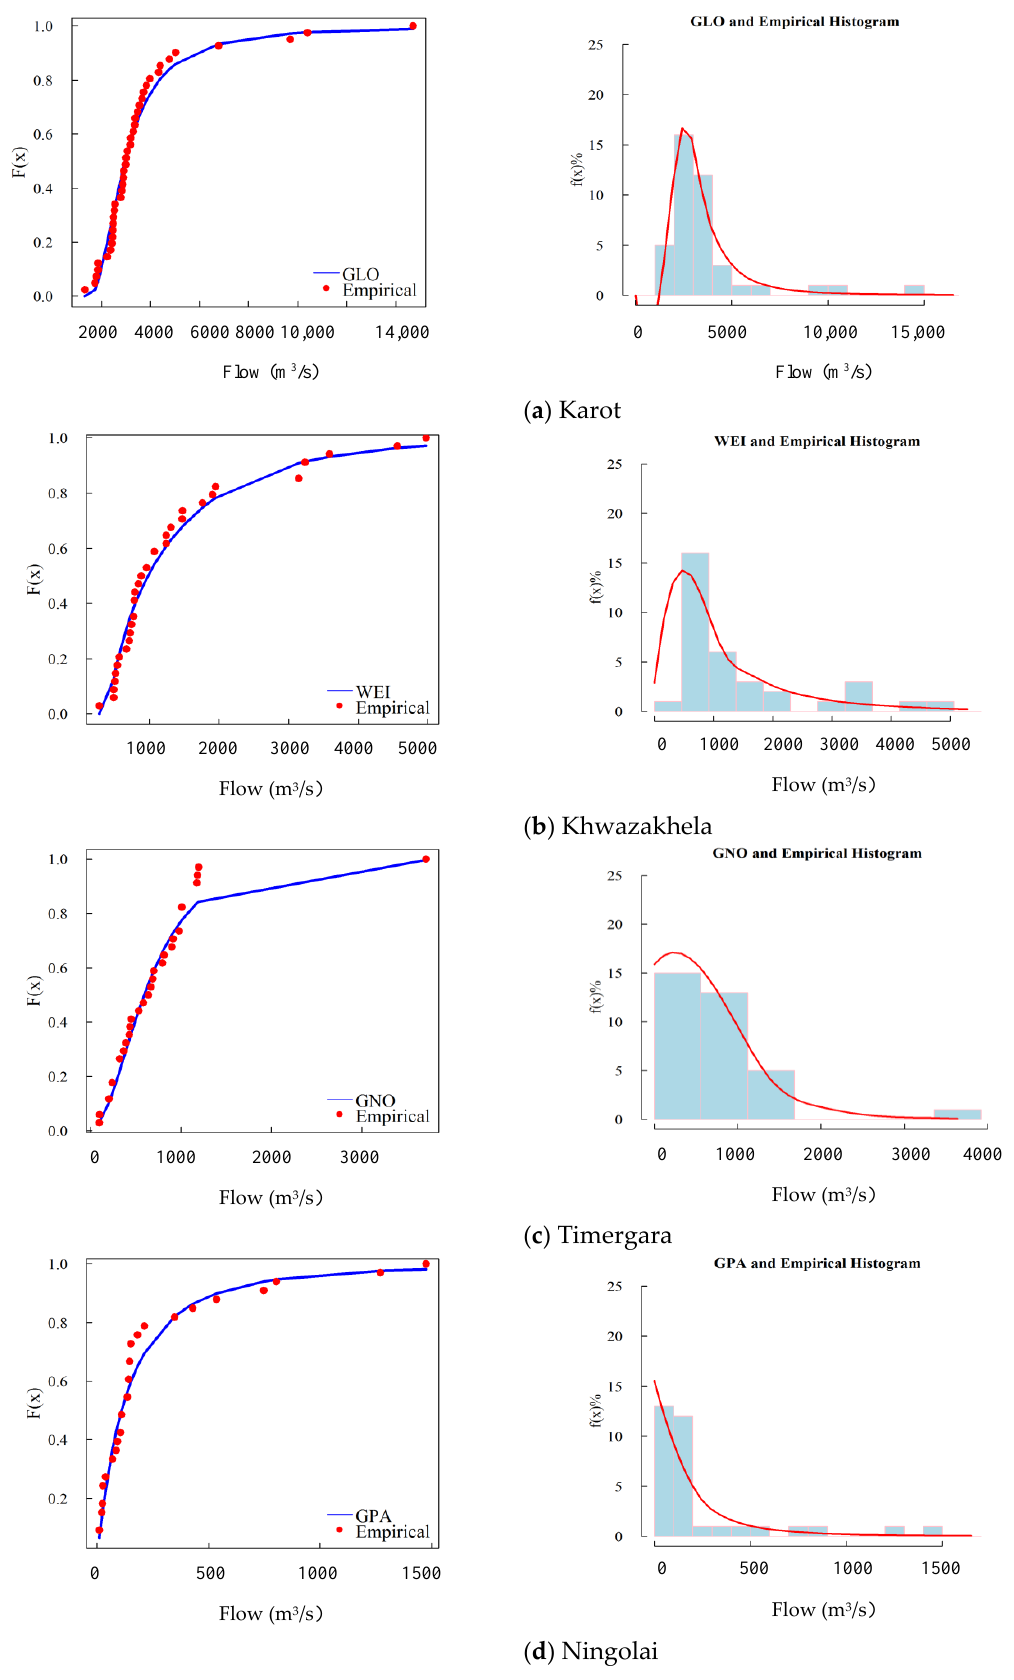
Figure 3. Cumulative distribution and the empirical histograms of fitted distributions for ( a ) Karot, ( b ) Khwazakhela, ( c ) Timergaraand ( d ) Ningolai.